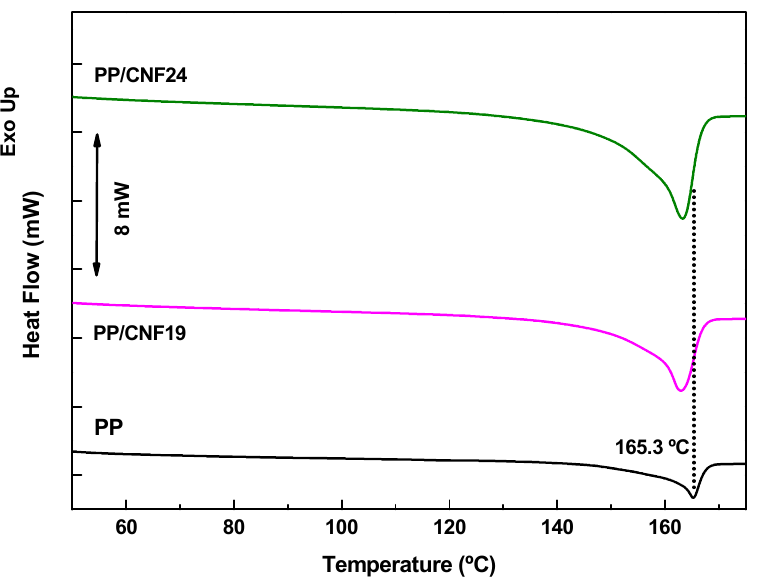
Figure 5. DSC thermographs of PP and PP/CNF composites, second heat. Table 3. DSC data of neat PP and PP/CNF composites corresponding to the second heating scans.